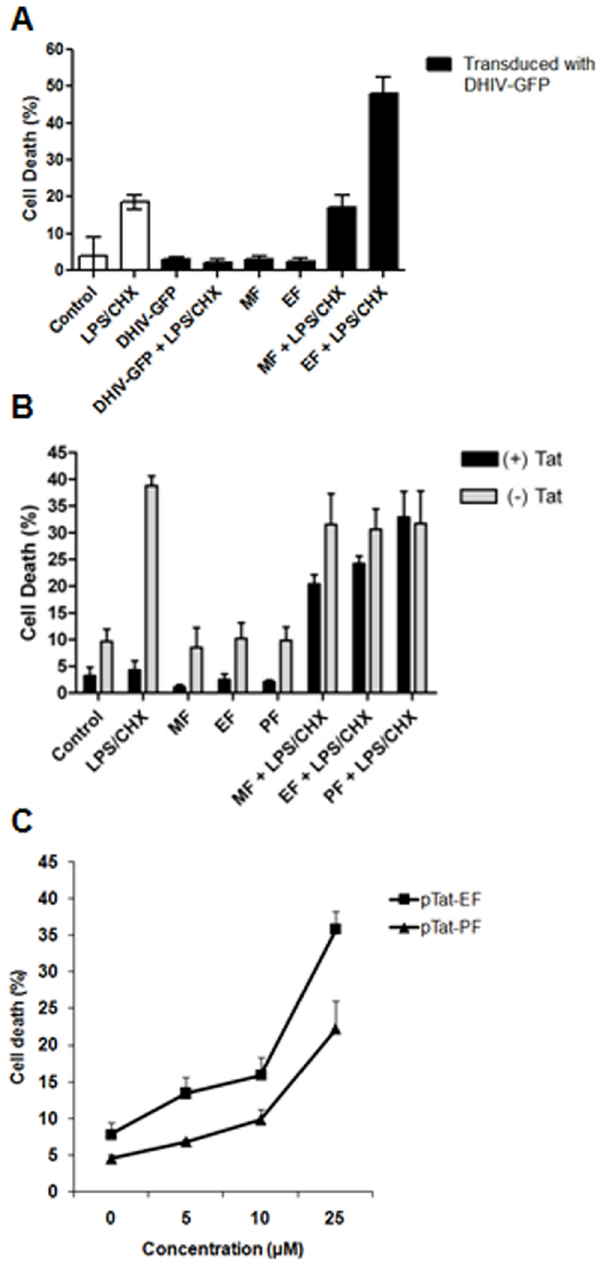
Figure 4. Counteracting effect of ALP compounds against the cytoprotective phenotype of HIV-1 or Tat expressing CHME5 cells. ( A ) Death of CHME5 cells untreated (‘‘Control’’) or treated with LPS (50 m g/ml) and CHX (10 m g/ml) (‘‘LPS/CHX’’) was determined by staining with ethidium homodimer (red) at 24 hours post treatment. CHME5 cells were also transduced by DHIV-GFP (‘‘D3’’, .